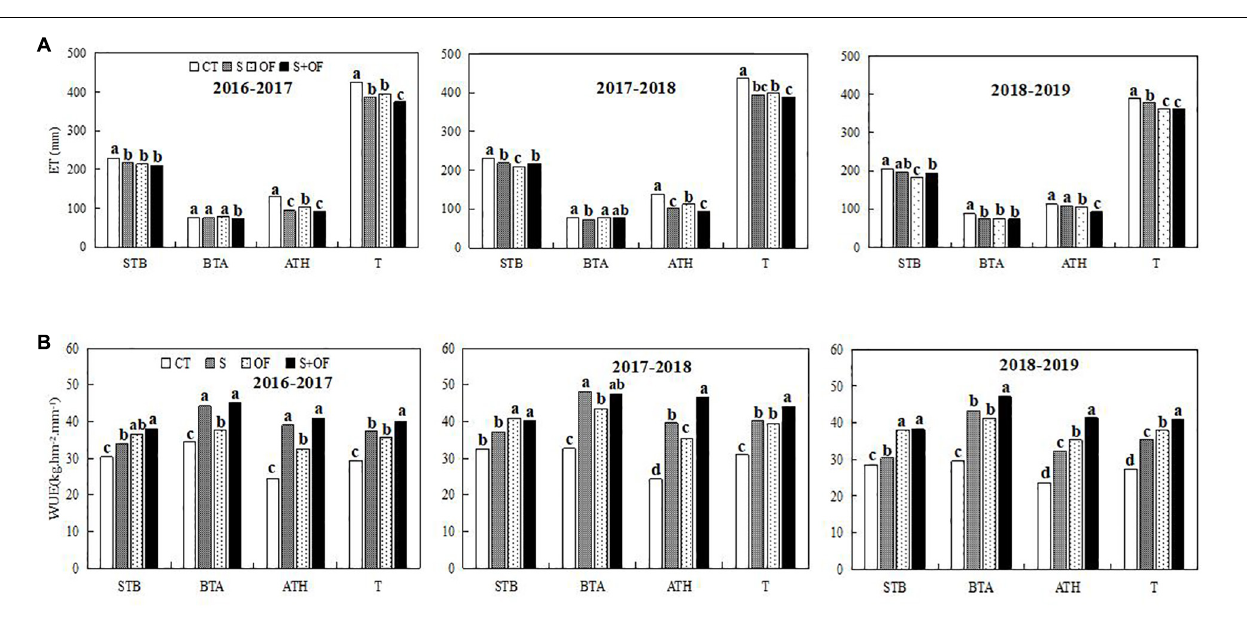
FIGURE 7 | Effects of subsoiling, organic fertilizer and subsoiling combined with organic fertilizer on water consumption (ET) (A) and water use efficiency (WUE) (B) at different growth stages of winter wheat in the three seasons of 2016–2019. Note: STB, sowing to booting; BTA, booting to anthesis; ATH, anthesis to